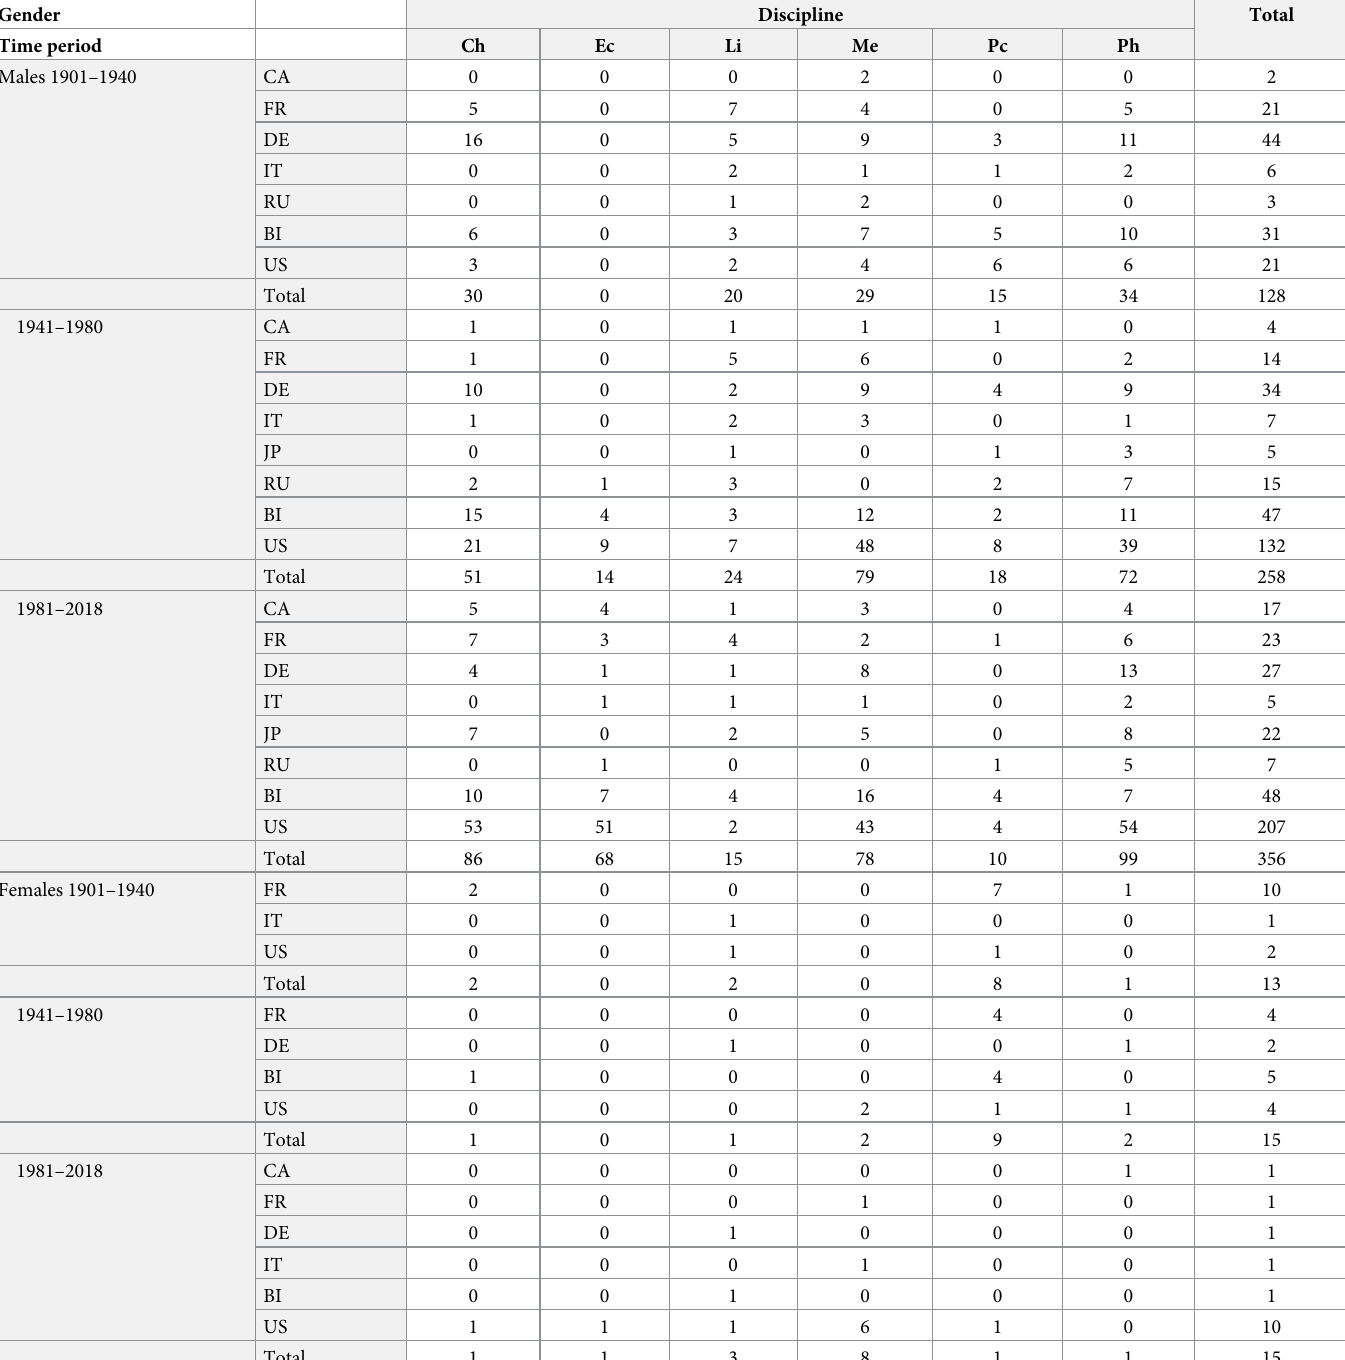
Table 1. Four-way contingency table from the cross-classification of Country and Discipline , based on Gender and Time period. Gender Discipline Time